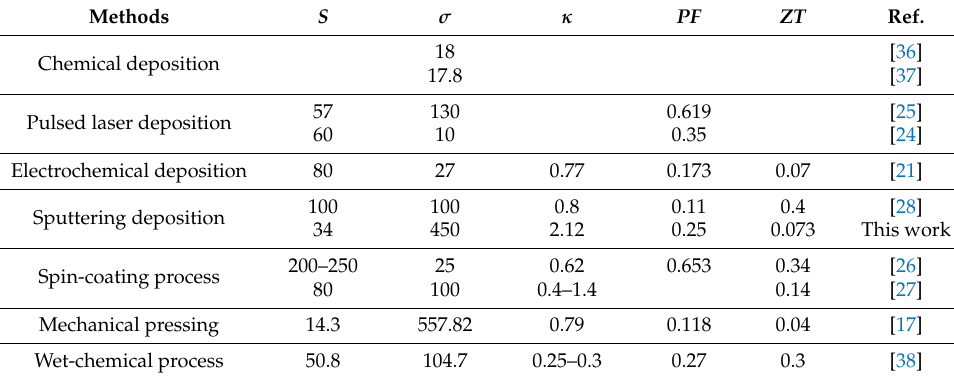
Table 3. Research progress of Cu2Se thin-film thermoelectric properties in recent years.